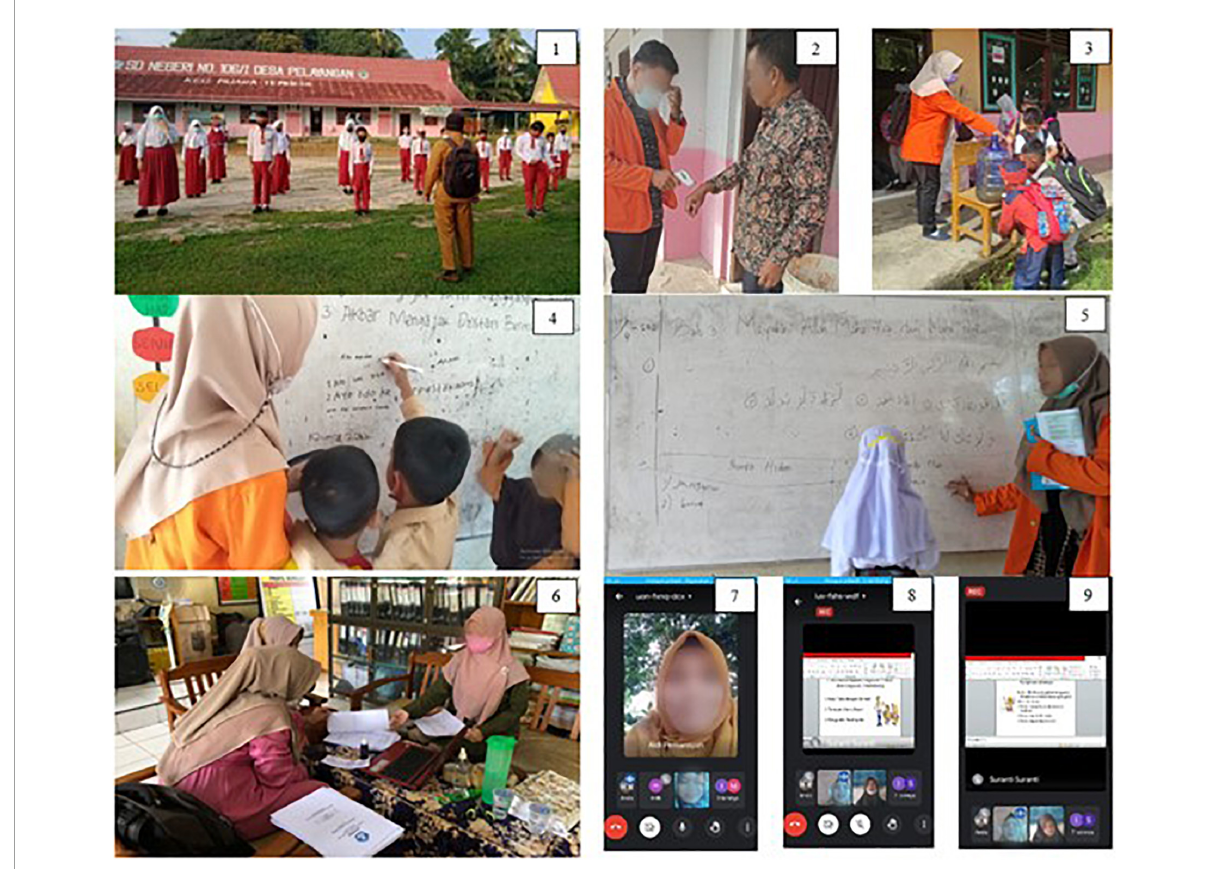
FIGURE2 Picture 1. Teaching campus student task setting at the State Primary School 106/I Paralayang, Batanghari, Jambi. 2. Application of health protocols. 3. Behavioral change education in washing hands for COVID-19 prevention. 4. Literacy and numeracy support. 5. Koranic literacy enrichment (QS. Al-Ikhlas [122]: 1–4). 6. School administration. 7. Students enable teachers to teach online via zoom with a smartphone. 8. Students show a presentation material slide, which is explained by the teacher. 9. Students accompany the teachers teaching online using a